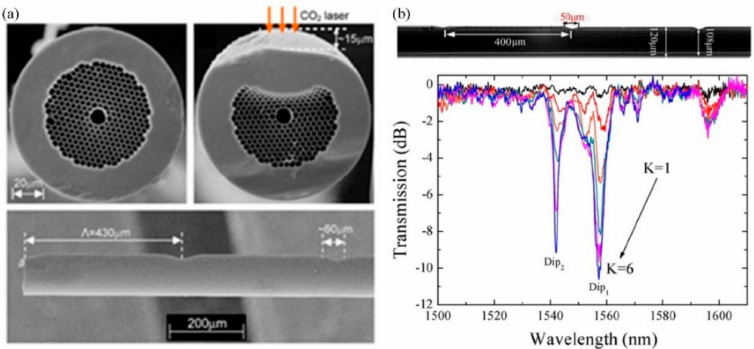
Figure 10. ( a ) Scanning electron micrographs of SLPFG in air-core photonic bandgap fiber with periodic notches; ( b ) transmission spectrum evolution of SLPFG while the scanning cycles increases [27,30].